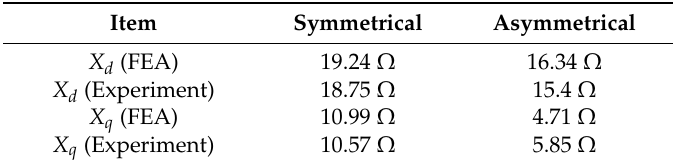
Table 5. Slow-slip results of two